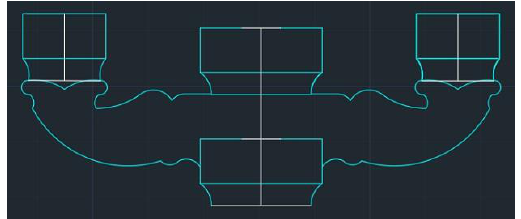
Figure 2. CAD drawing of a building component (Center for Cultural Sites Rehabilitation and Development,